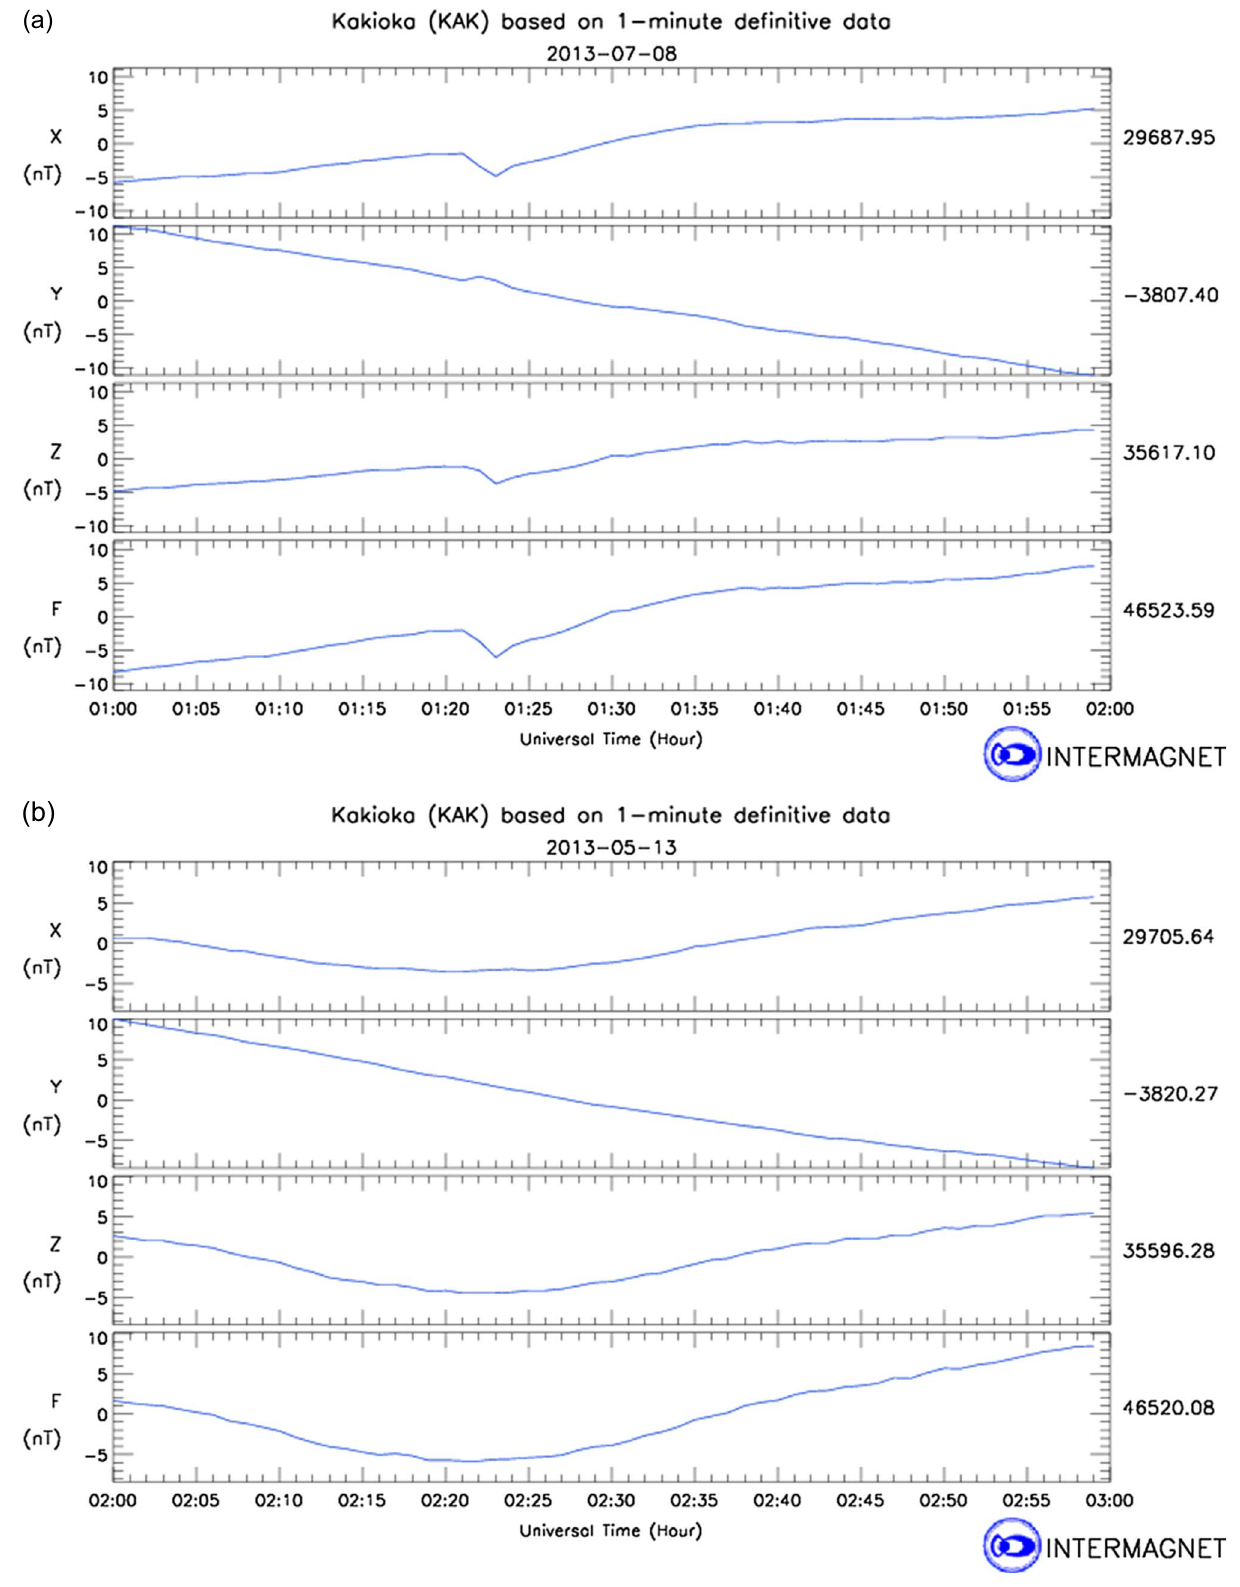
Fig. 11. (a) Sfe at KAK produced by a C9.7 fl are (July 8, 2013, at 01:21 UT). The variation D B was 7 nT but with a duration, D t , of 10 min. (b) Sfe at KAK produced by a X2.2 fl are (May 13, 2013, at 01:57 UT). The variation D B was 15 nT but with a duration, D t , of 35